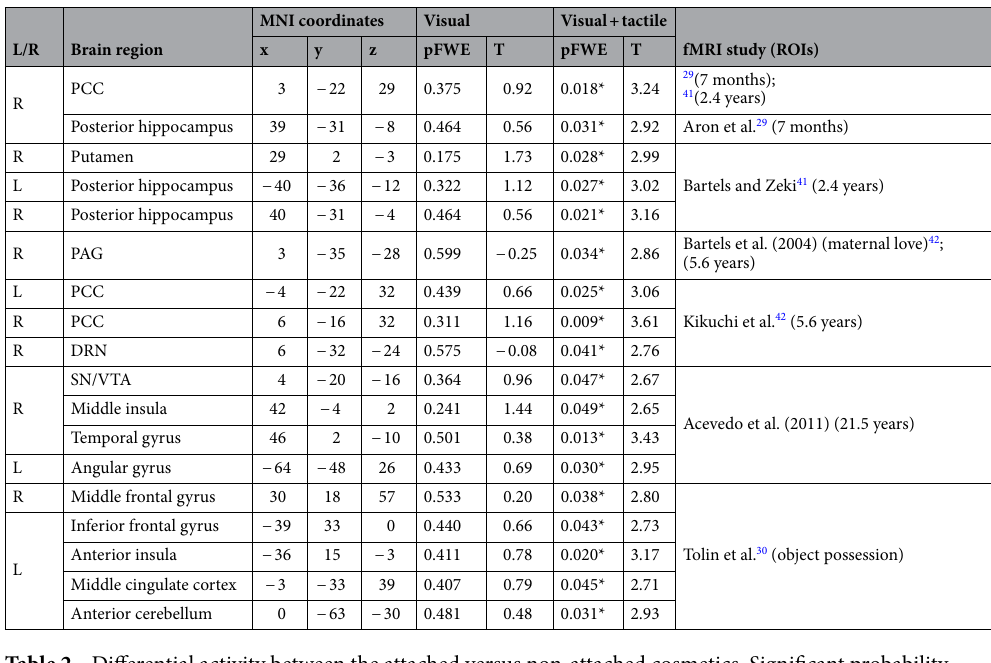
Table 2. Differential activity between the attached versus non-attached cosmetics. Significant probability (pFWE) and T value of each ROI activity are shown in each session (SVC, p < 0.05 FWE).